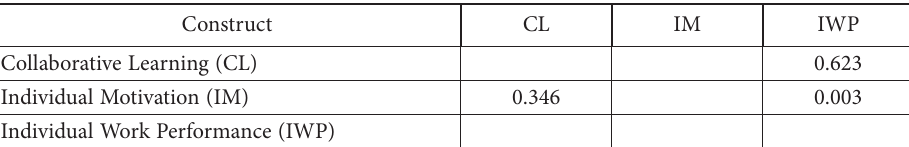
Table 8. f² values Construct CL IM IWP Collaborative Learning (CL) 0.623 Individual Motivation (IM) 0.346 0.003 Individual Work Performance